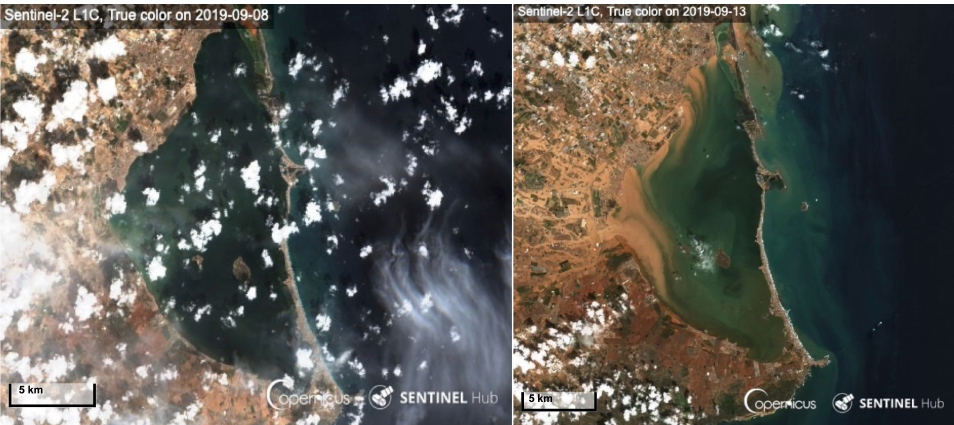
Figure 8. Satellite images of the Mar Menor before ( a ) and after ( b ) the DANA event of Septem- ber